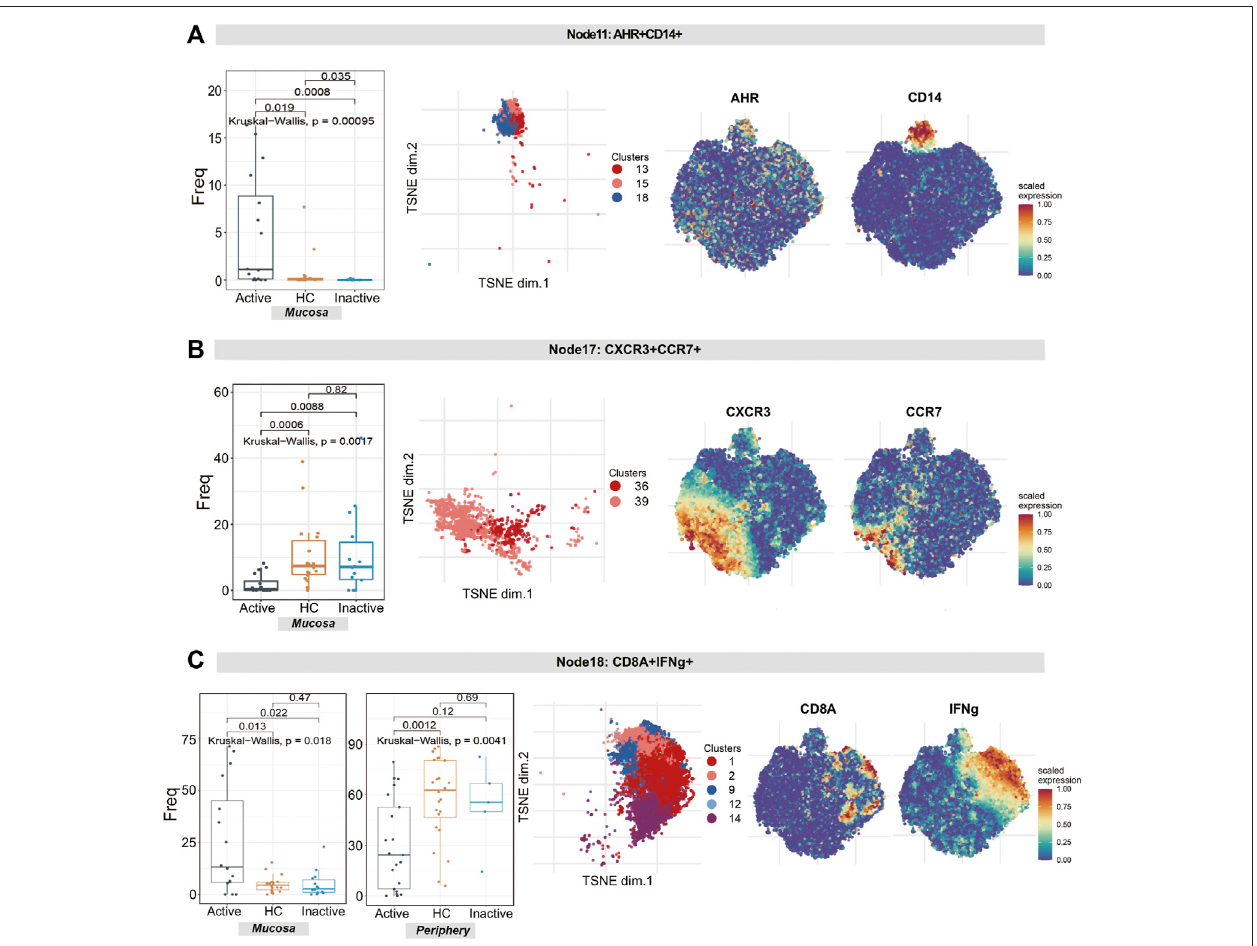
FIGURE 7 | Natural killer cell analysis revealed the diversity of cytotoxic NK cells and tolerant NK cells in UC patients and HCs. (A – C) Abundance boxplots and t-SNE plots of node 11 (A) , node 17 (B) and node 18 (C) in NK cells, with respective selected marker heatmaps for reference.